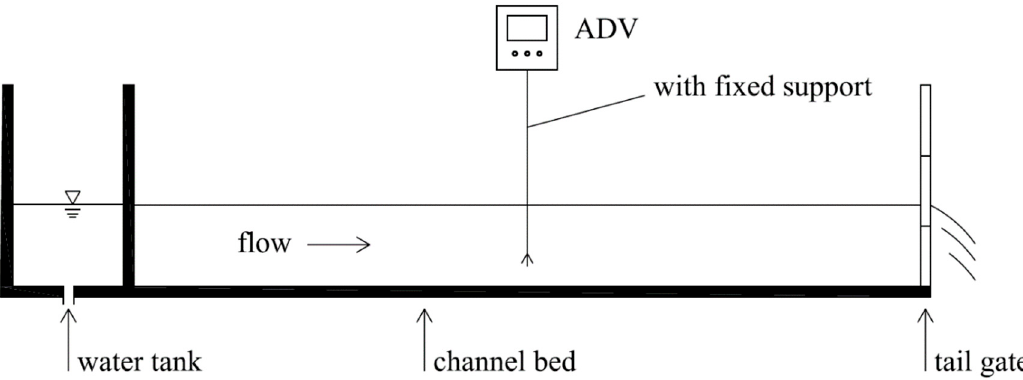
Figure 6. Schematic of the experimental device at China Agricultural University (CAU), China.